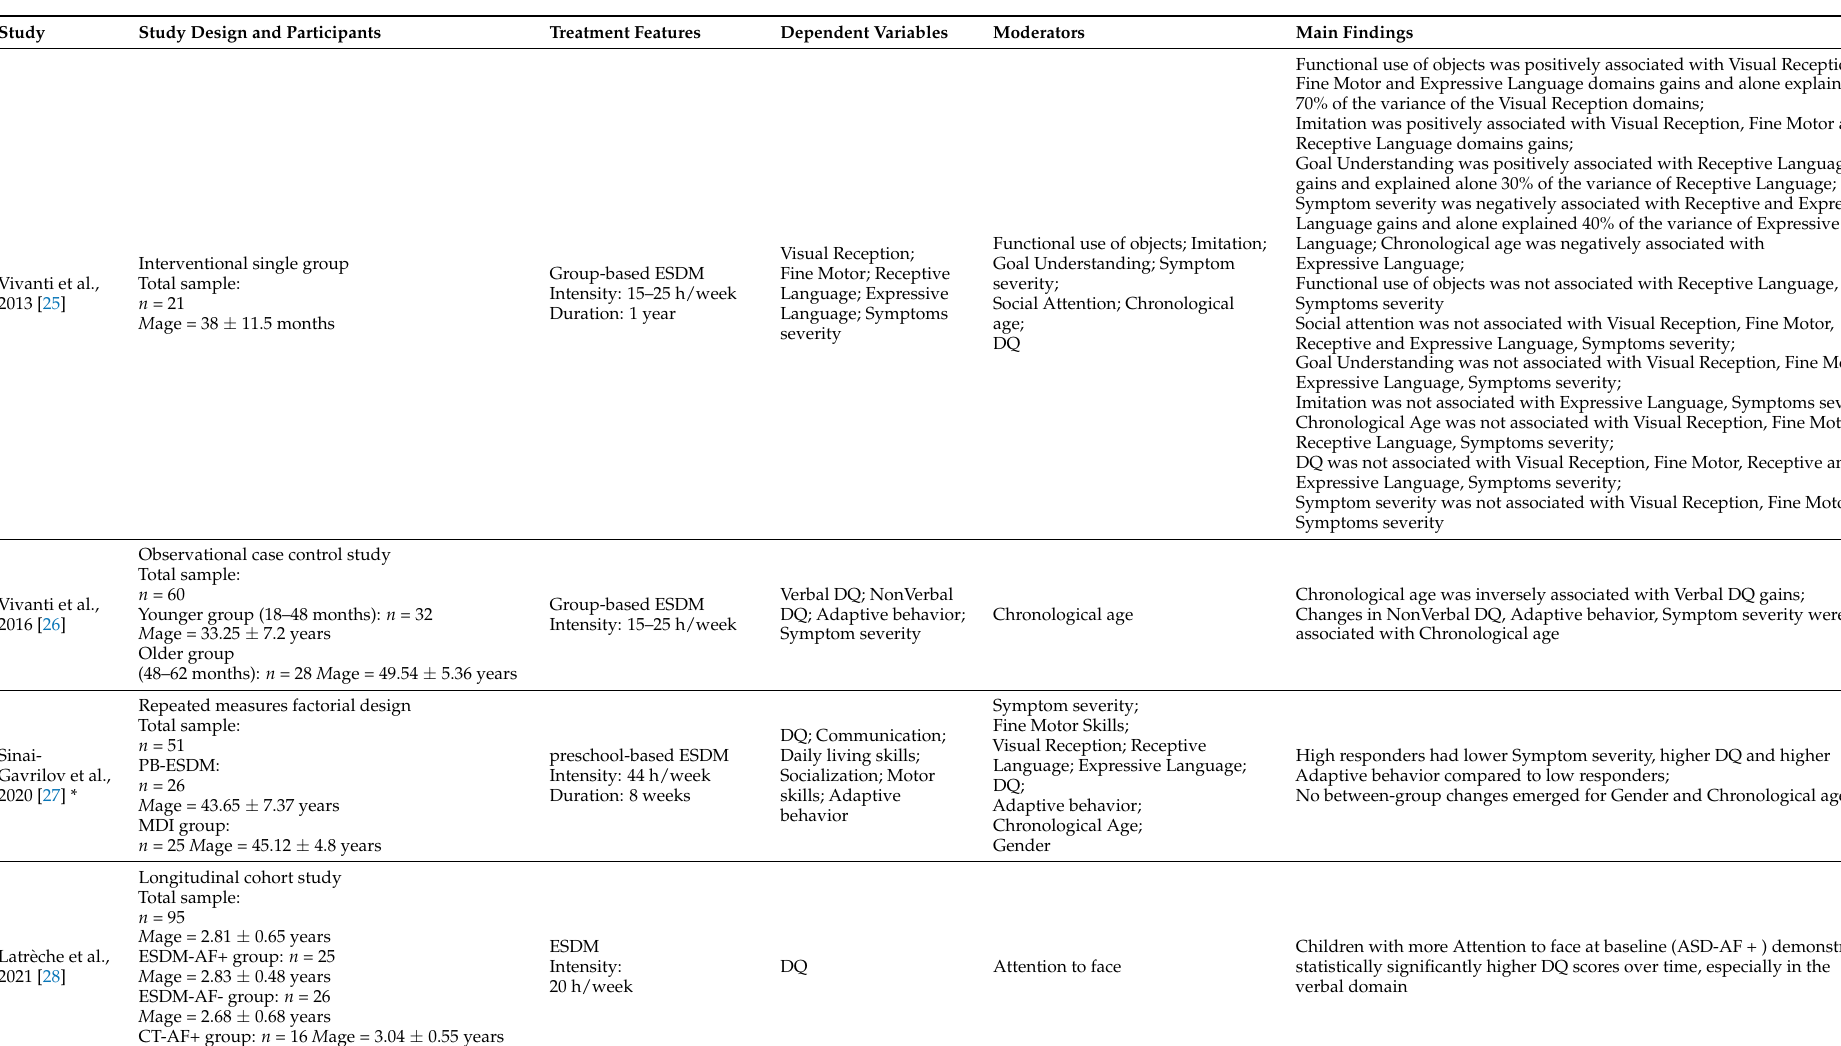
Table 1. Summary of Studies Included in Review ( n =